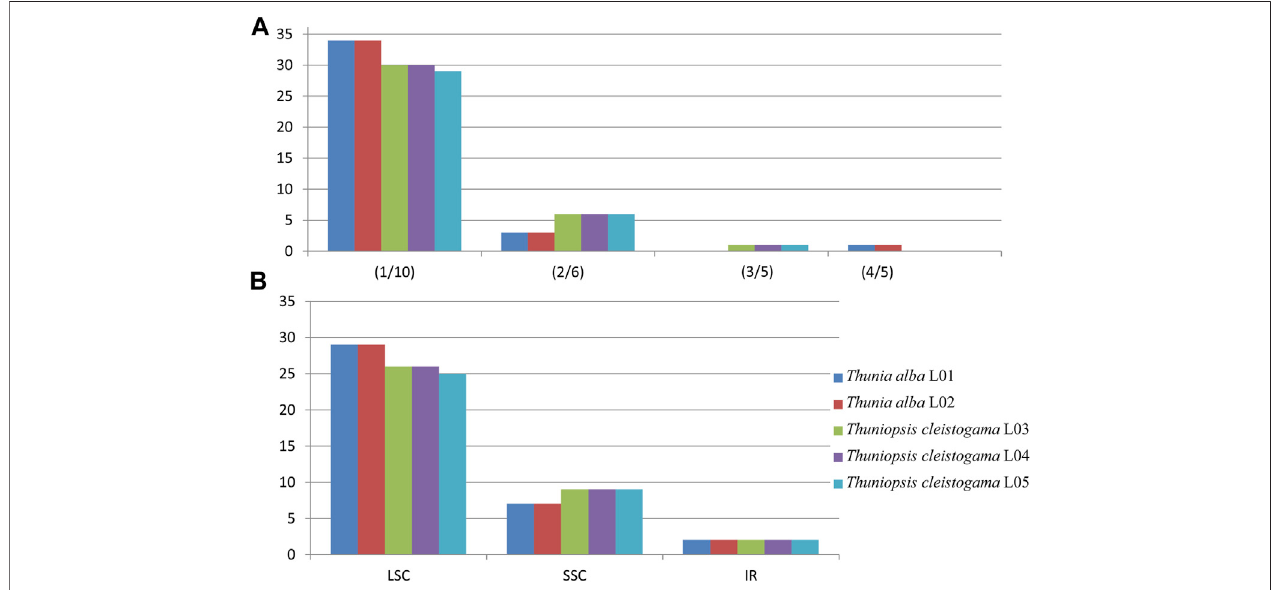
FIGURE 3 | The type and distribution of chloroplast simple sequence repeats (cpSSRs) in the cp genomes from the fi ve individuals of Thuniopsis cleistogama and Thunia alba . (A) Frequencies of cpSSRs identi fi ed in different repeat types. (B) Number of cpSSRs in different regions.